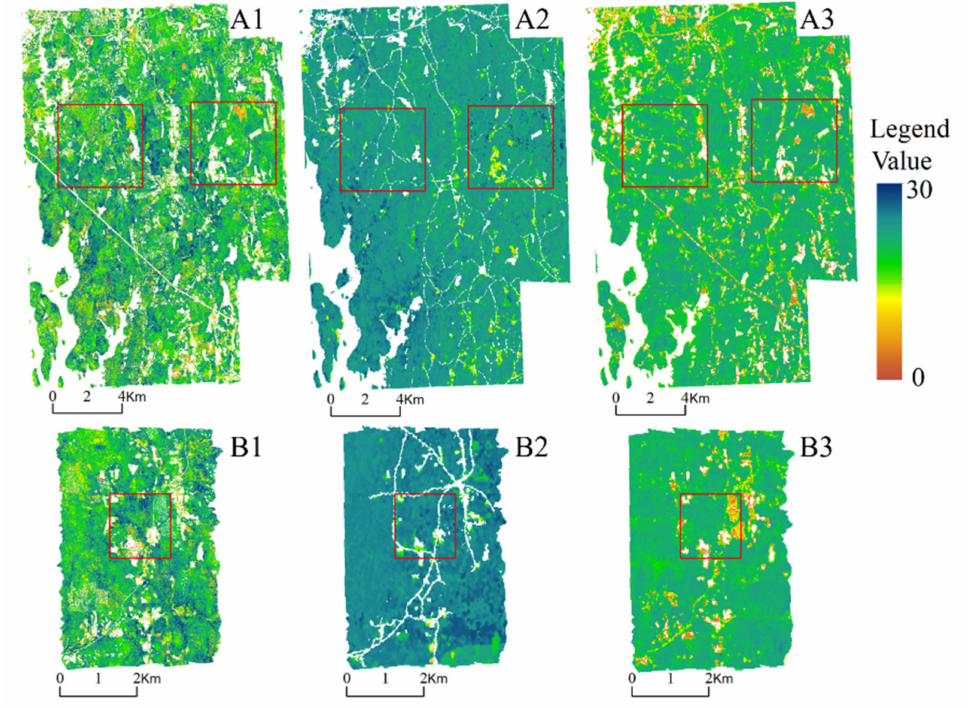
Figure A2. The distribution of NEON RH95 ( A1 , B1 ), C-CH ( A2 , B2 ), and GDAL height ( A3 , B3 ) in HARV ( A ) and HOPB ( B ) sites.